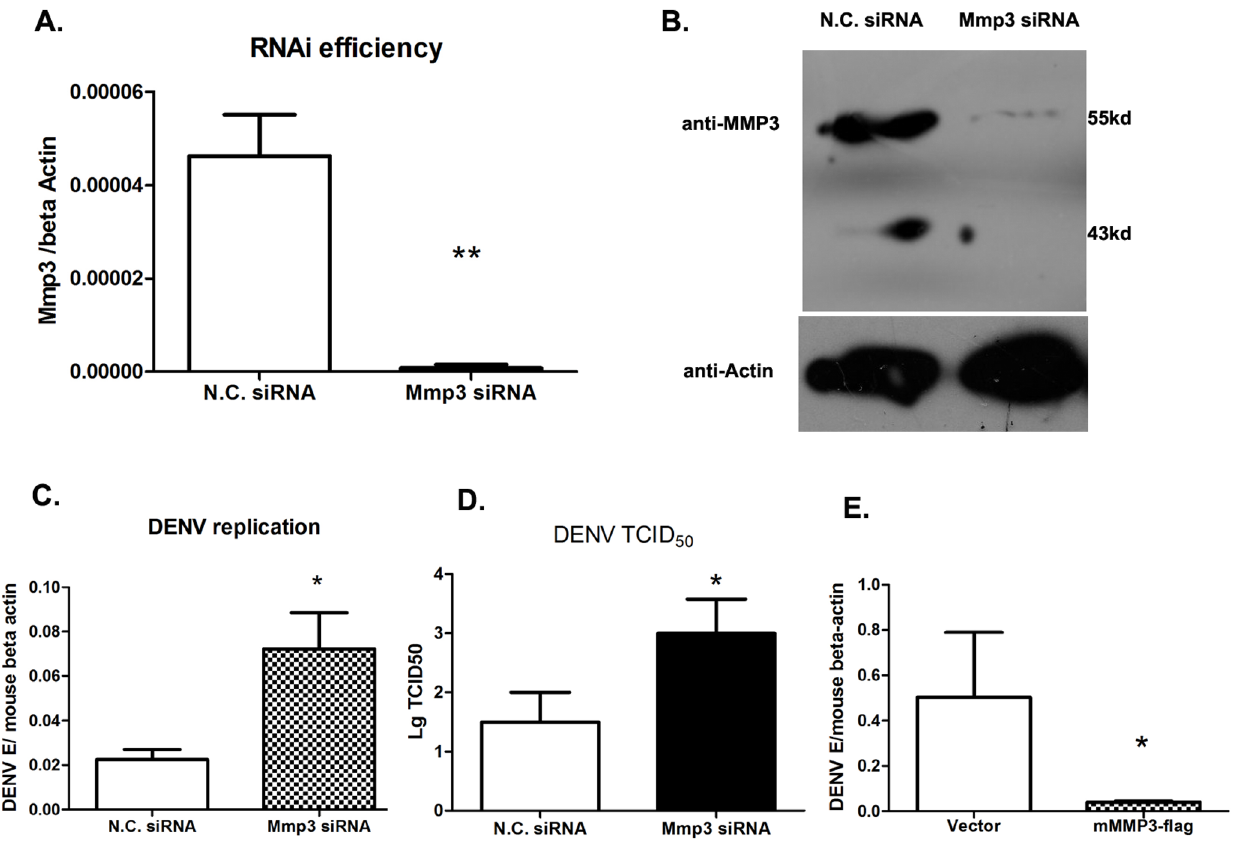
Figure 2. The antiviral effect of Mmp3 against DENV. A-B) RNAi efficiency for Mmp3 as shown in qRT-PCR (A) and Western blot (B). C-D) DENV burdens in RAW264.7 cells after RNAi silencing. C) The viral burdens were analyzed by measuring the virus E gene copy using qRT-PCR, and normalized to mouse beta actin gene. D) The titer of infectious DENV in cell supernatants 24 hrs post infection, as measured by TCID 50 assay. E) The viral burdens in Mmp3 overexpressed cells were decreased comparing with that in control cells. Results are expressed as the mean + the SEM. * p , 0.05 and ** p , 0.01( t -test). Representative results from at least 3 independent experiments.